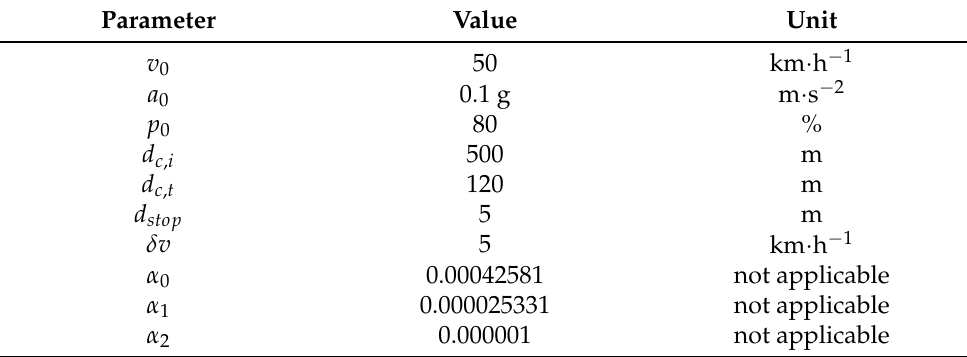
Table 2. Simulation parameters (road-related) used in this work.